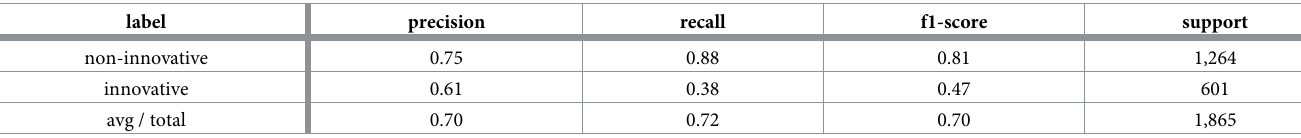
Table 6. Product innovator classification report for alternative data test set B.